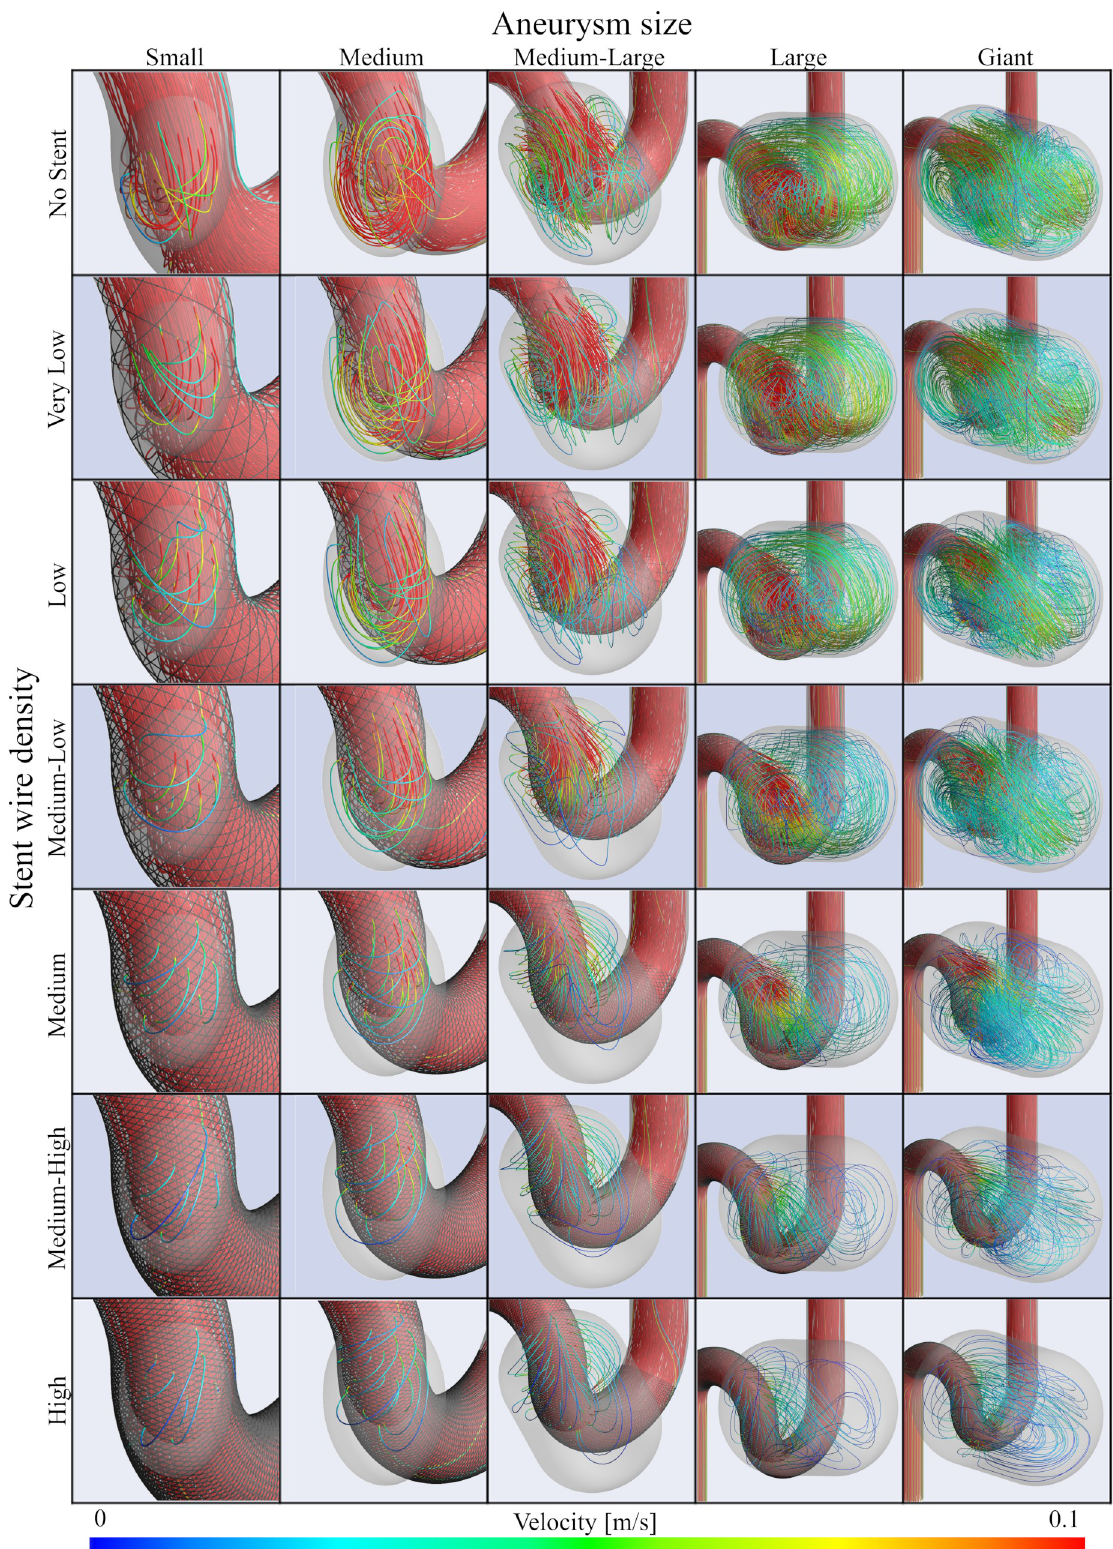
Fig 3. Streamlines before and after stent deployment in each aneurysm size and stent wire mesh density. The streamlines are sampled from the second systole and colored in the range of 0–0.1 m/s according to the velocity. https://doi.org/10.1371/journal.pone.0269675.g003 PLOS ONE | https://doi.org/10.1371/journal.pone.0269675 June 10,